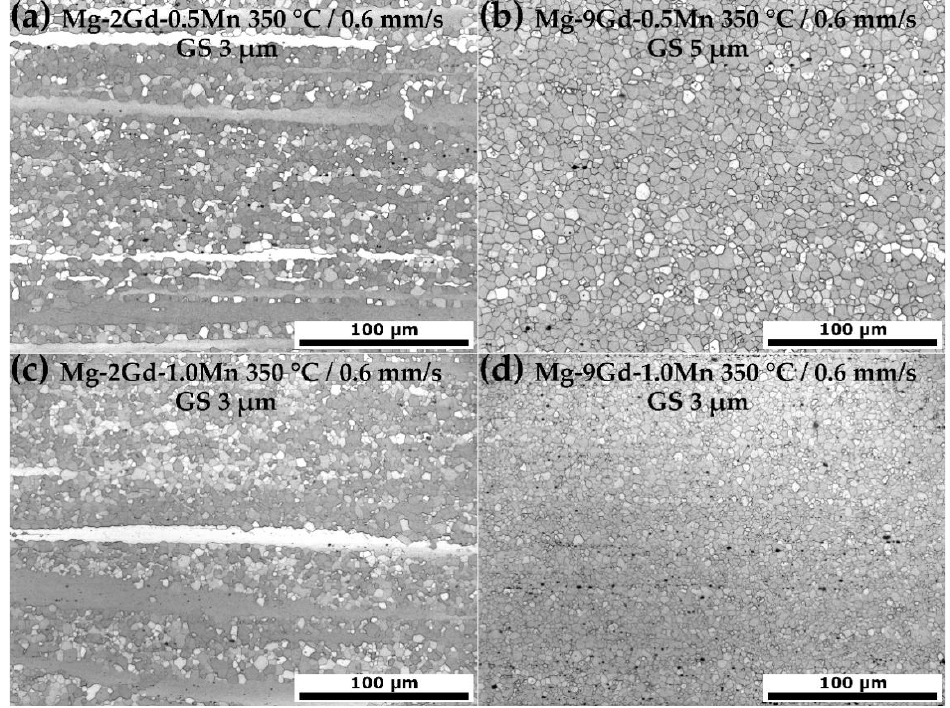
Figure 2. Light optical micrographs with average grain size (GS) of Mg-2Gd and Mg-9Gd with 0.5 and 1.0 wt.% Mn with respect to extrusion temperature (extrusion direction horizontal).